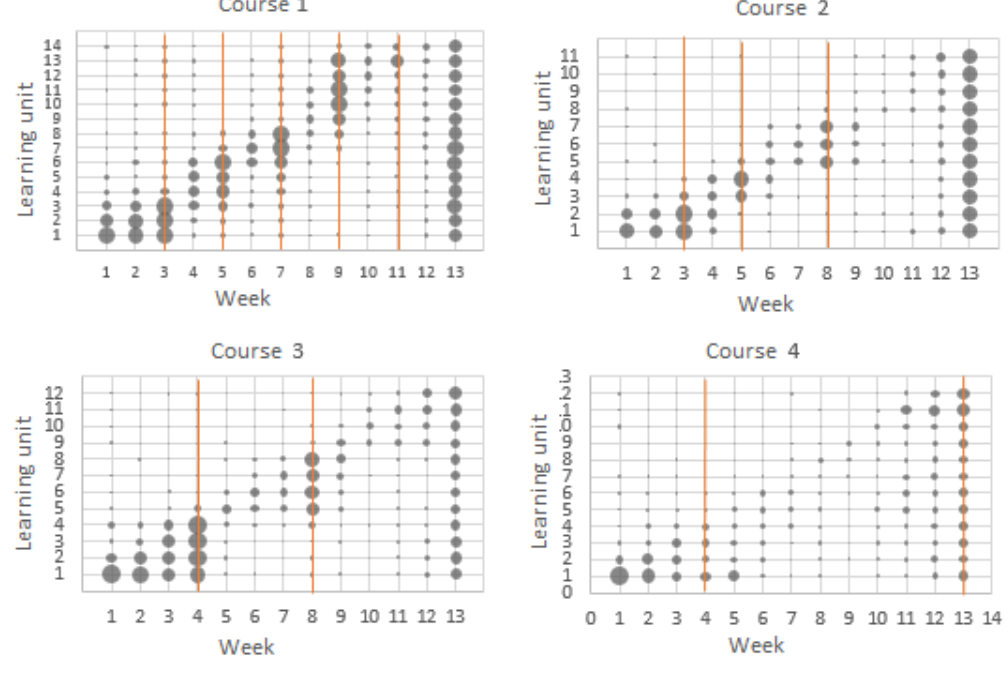
Figure 5 . Use of the flexibility of order of access to the learning